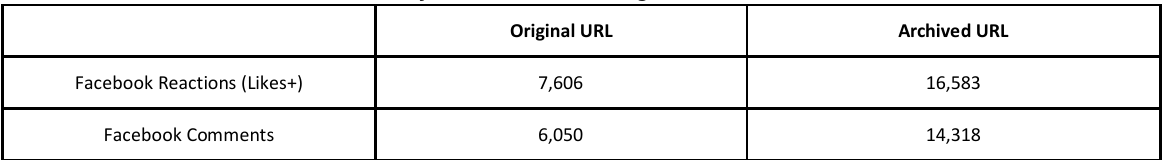
Table 1. Engagement data from CrowdTangle comparing original URL and archived URL. The Wayback Machine URL outperformed on every Facebook engagement metric, thus spreading misinformation farther than the original